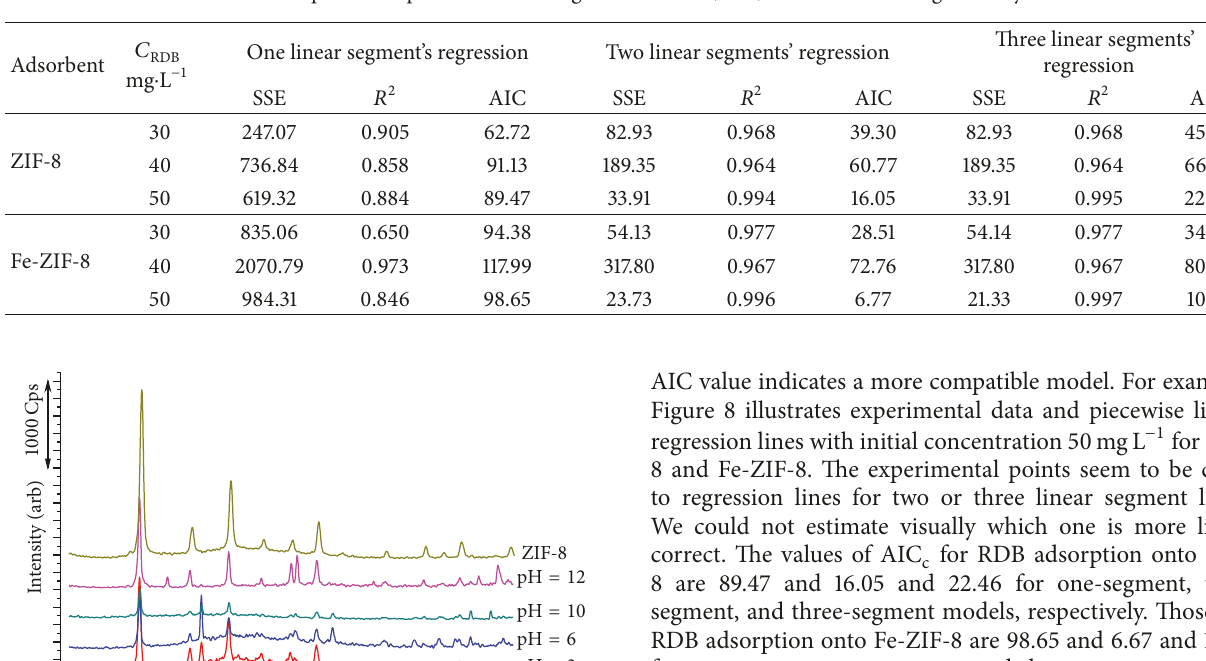
Figure 5: TGA-DTA of ZIF-8 and Fe-ZIF-8. Table 3: Comparison of piecewise linear regression for one, two, and three linear segments by AIC.